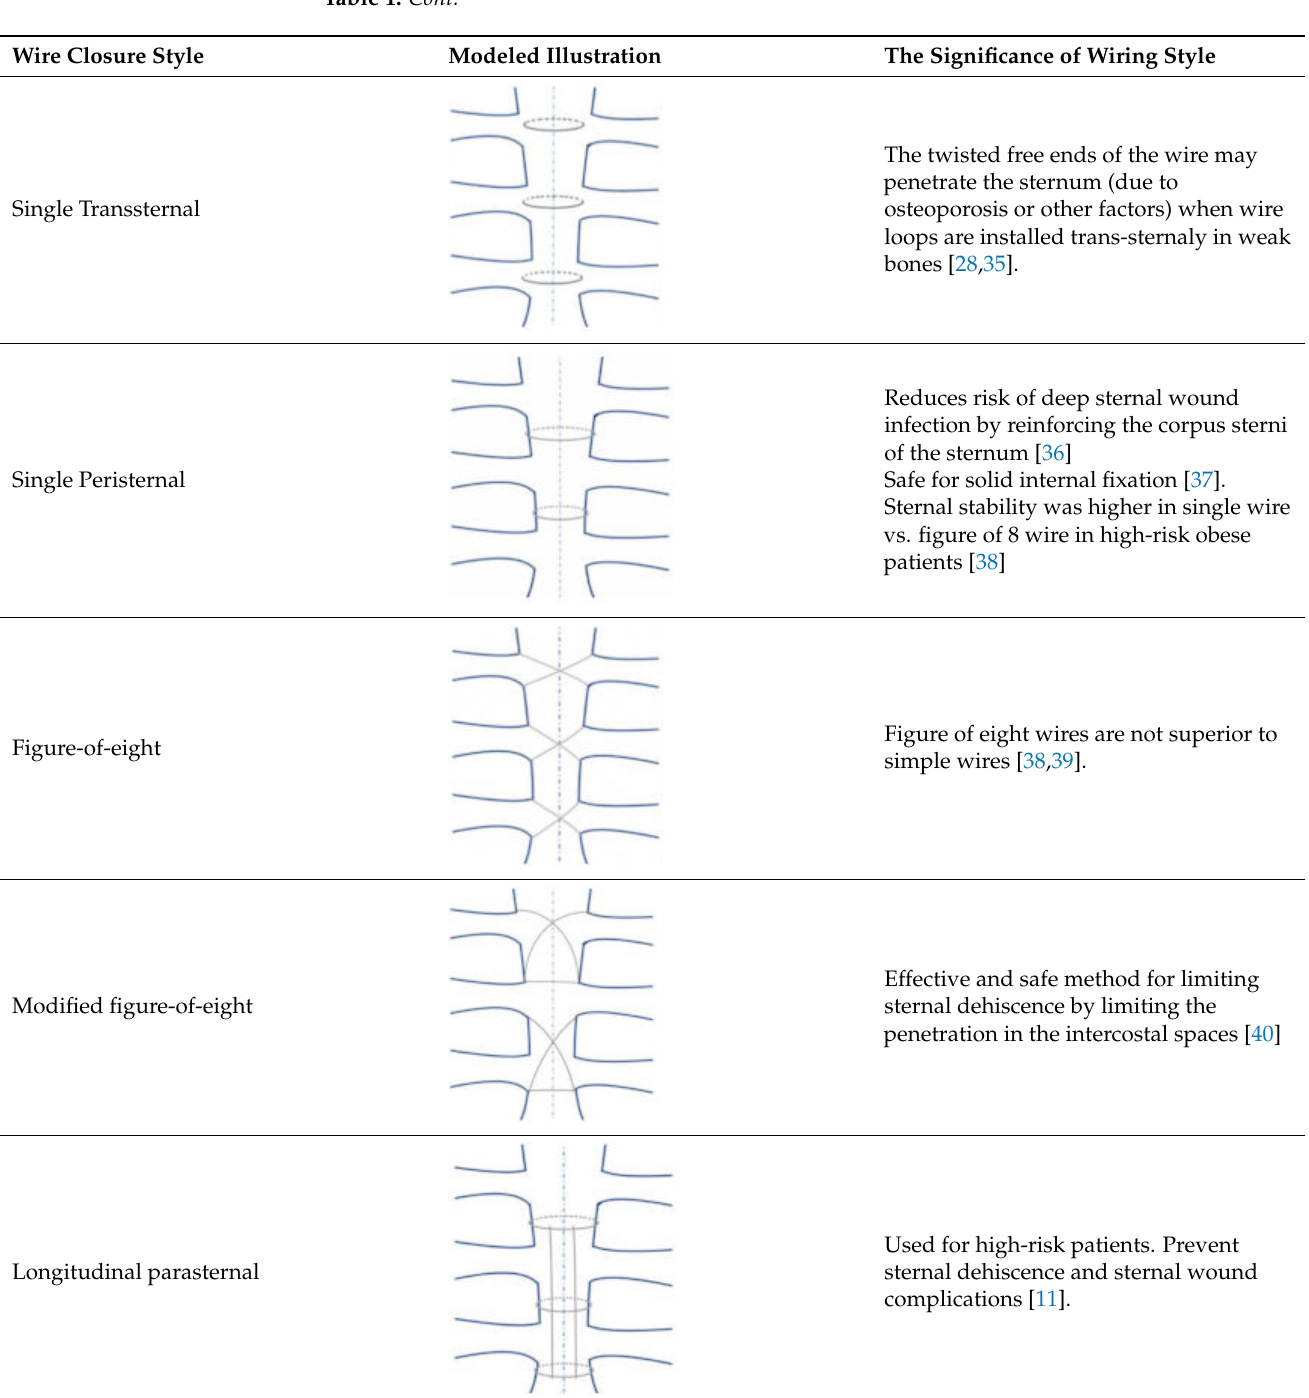
Figure of eight wires are not superior to simple wires